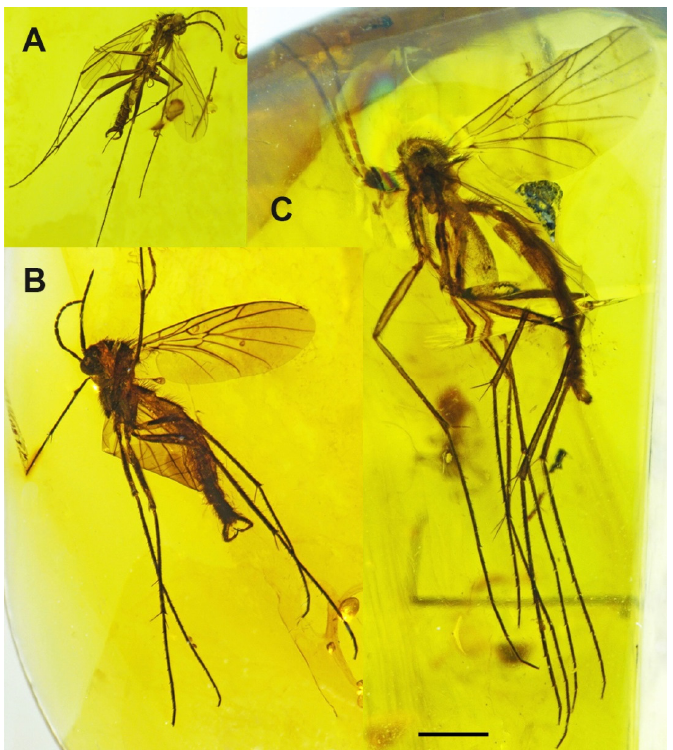
Figure 1. Habitus photographs of Paleoplatyura agnieszkae sp. nov. (( A ) holotype), P. miae sp. nov. (( B ) holotype), and P. magnifica sp. nov. (( C ) holotype). Scale bar = 1 mm.